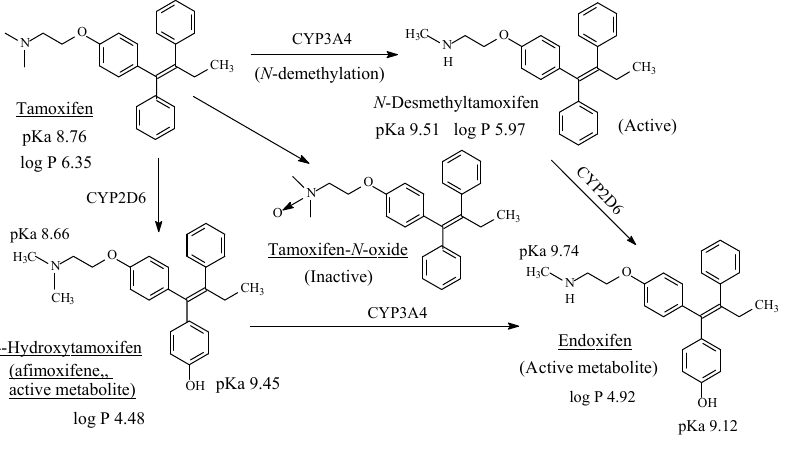
Figure 42. Metabolic pathways of tamoxifen.